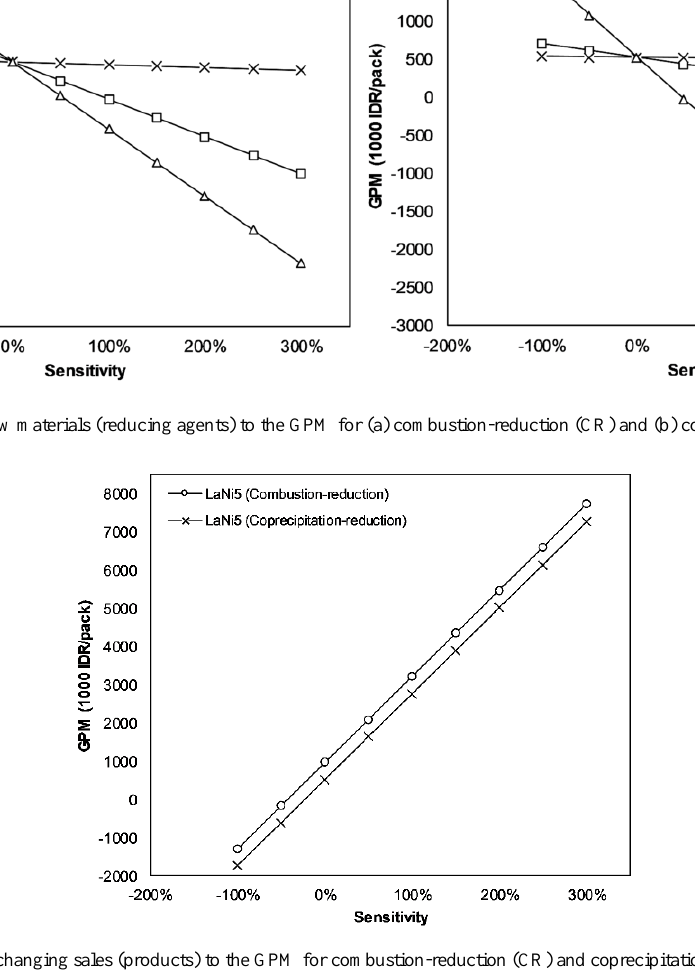
Fig. 5. Effect of changing sales (products) to the GPM for combustion-reduction (CR) and coprecipitation-reduction